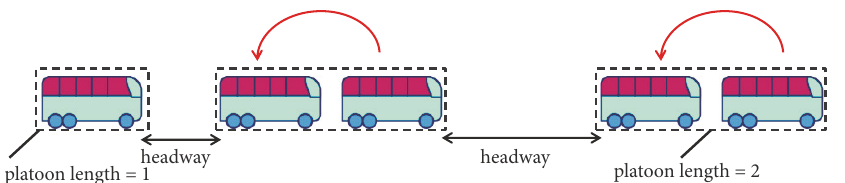
Figure 1: Illustration of bus platoons. The arrows indicate the vehicle-to-vehicle(V2V) wireless